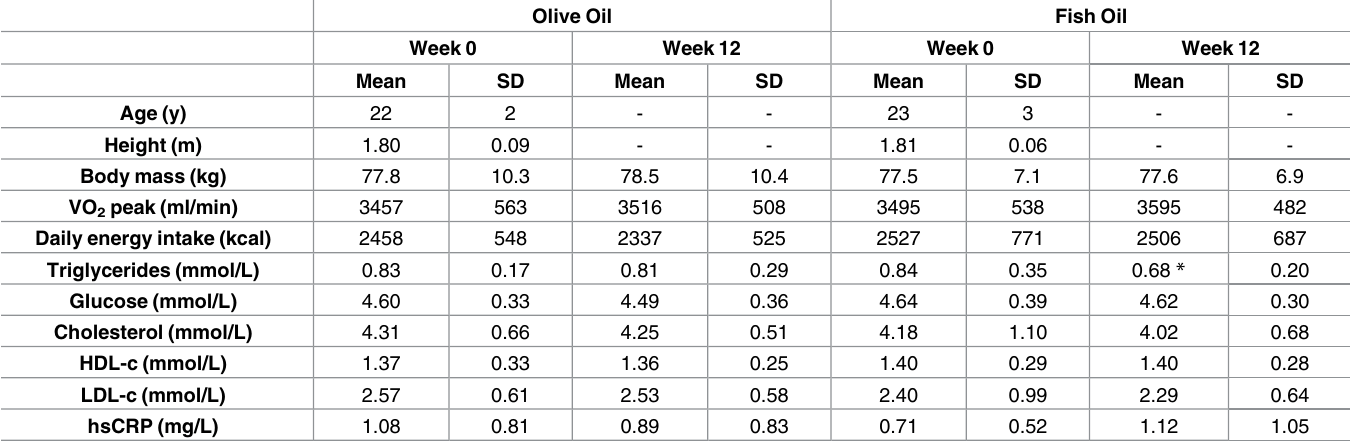
Table 1. Subject characteristics and blood